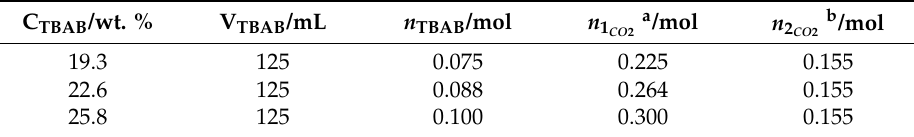
Table 3. Theoretical value of CO 2 storage in different conditions.